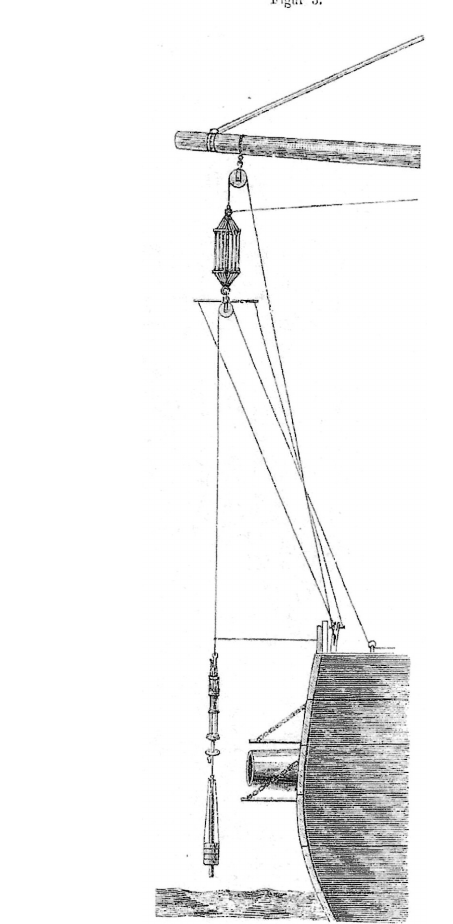
Figure 6. Reproduction of Fig. 3 (p. 16) of the Gazelle narrative showing the deployment of a Baillie